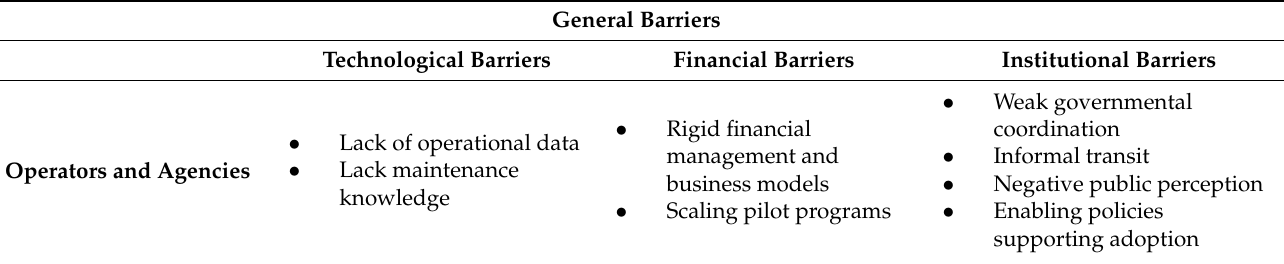
Table 5. Barrier to Electric and Fuel-Cell Buses in